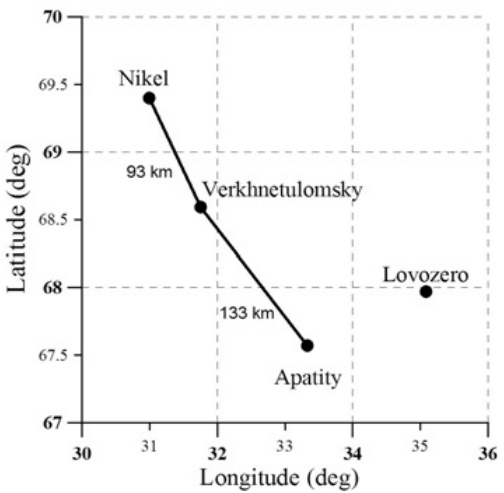
Fig. 1. The experiment geometry showing the locations of the scan- ning photometers.